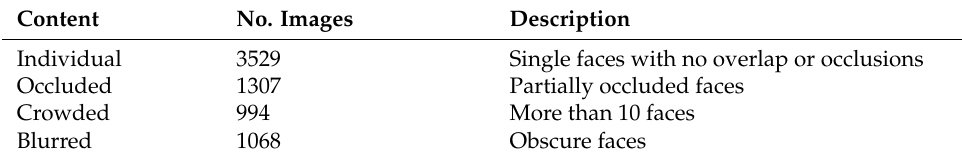
Table 1. FaceMask Contents. Content No. Images Description